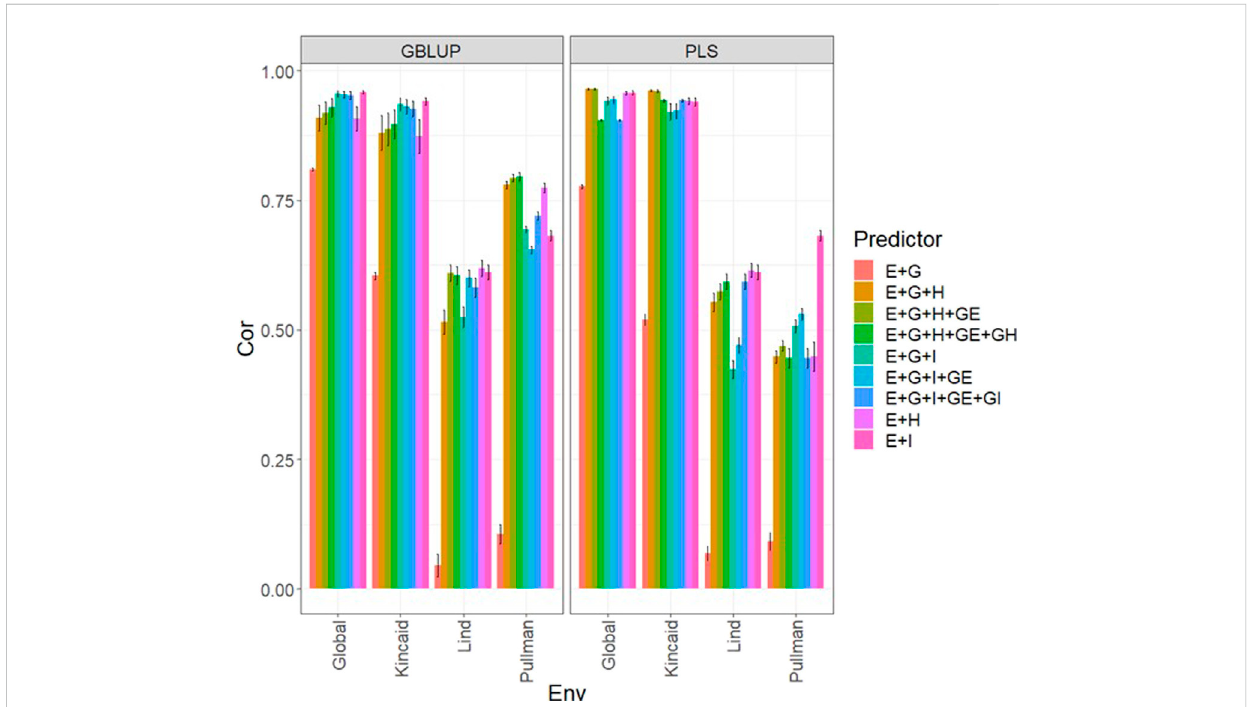
FIGURE 1 Dataset 1 (year 2019). Pearson´s correlation (Cor) and their corresponding Standard Error (SE) for each location and across location (Global) under tested lines in tested environments (7FCV) for nine evaluated predictors under a GBLUP and PLS models.